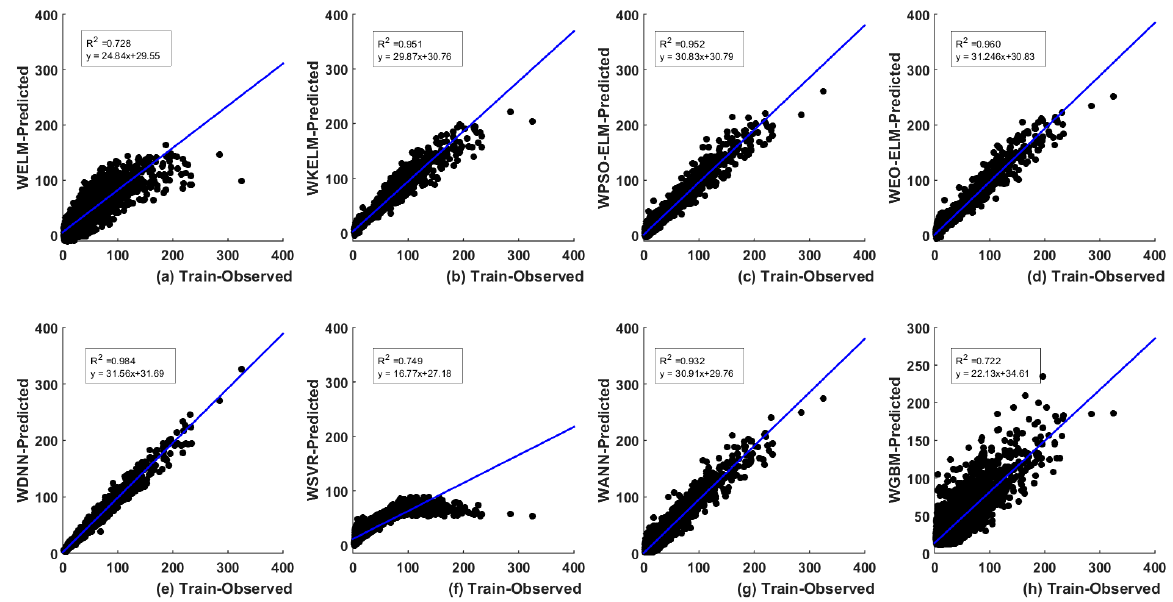
Figure 17. Prediction capability of the eight models in train case ( a ) WELM, ( b ) WKELM, ( c ) WPSO-ELM, ( d ) WEO-ELM, ( e ) WDNN, ( f ) WSVR, ( g ) WANN, and ( h ) WGBM for the catchment Teifi at Glanteifi.